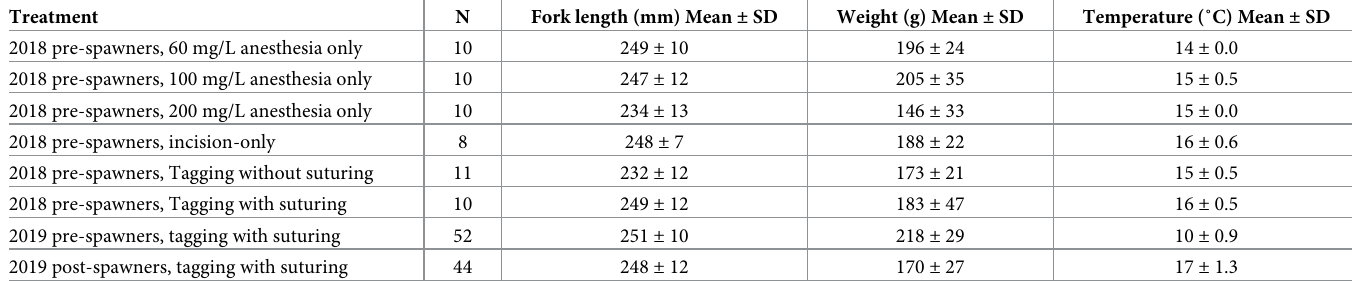
Table 1. Average weight, length and water temperature parameters of alewife trial groups across the 2018 and 2019 field